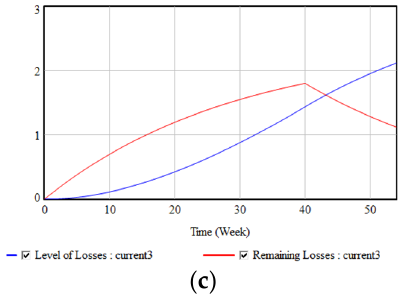
Figure 3. ( a ) Simulation results for 𝑉 (cid:2869)(cid:2869) : Work Done and Work to Do . ( b ) Simulation results for 𝑉 (cid:2869)(cid:2869) : Level of Rework and Remaining Rework . ( c ) Simulation results for 𝑉 (cid:2869)(cid:2869) : Level of Losses and Remaining Losses .